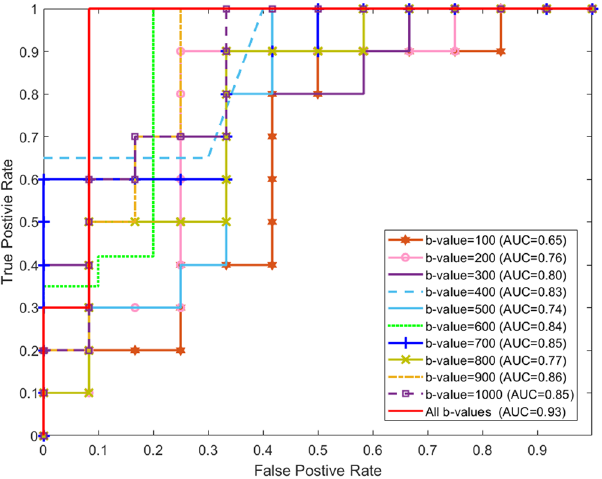
Figure 6. Receiver operating characteristics (ROC) curves for the FBio scenario for individual b-values and their fusion.